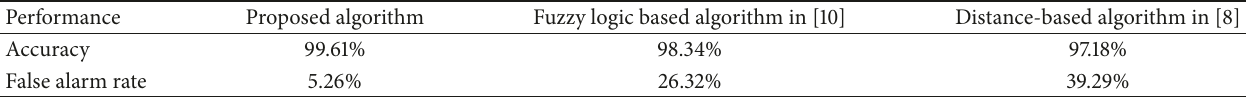
Table 3: The confusion matrix of the identification